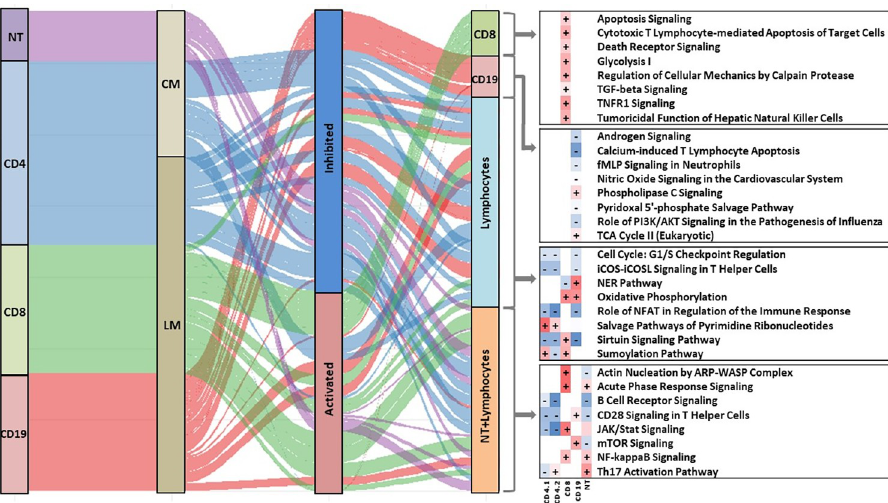
Fig 6. Common and unique pathways in lymphocytes & nasal epithelial cells of integration models. Sankey diagram showing the common and unique pathways among lymphocytes & nasal epithelial cells of integration model of CD4, nasal epithelial cells and microbiota (M1) and model of lymphocytes (M4). Ingenuity Pathway Analysis (IPA) was used to identify canonical pathways represented by genes associated with severity in lymphocytes and nasal epithelial cells. Pathways are shown where Fisher’s exact test p-values were less than 0.05. Red and blue indicate predicted increased or decreased pathway activation (activation z-score), respectively. The width of the flow bar is proportional to absolute value of activation